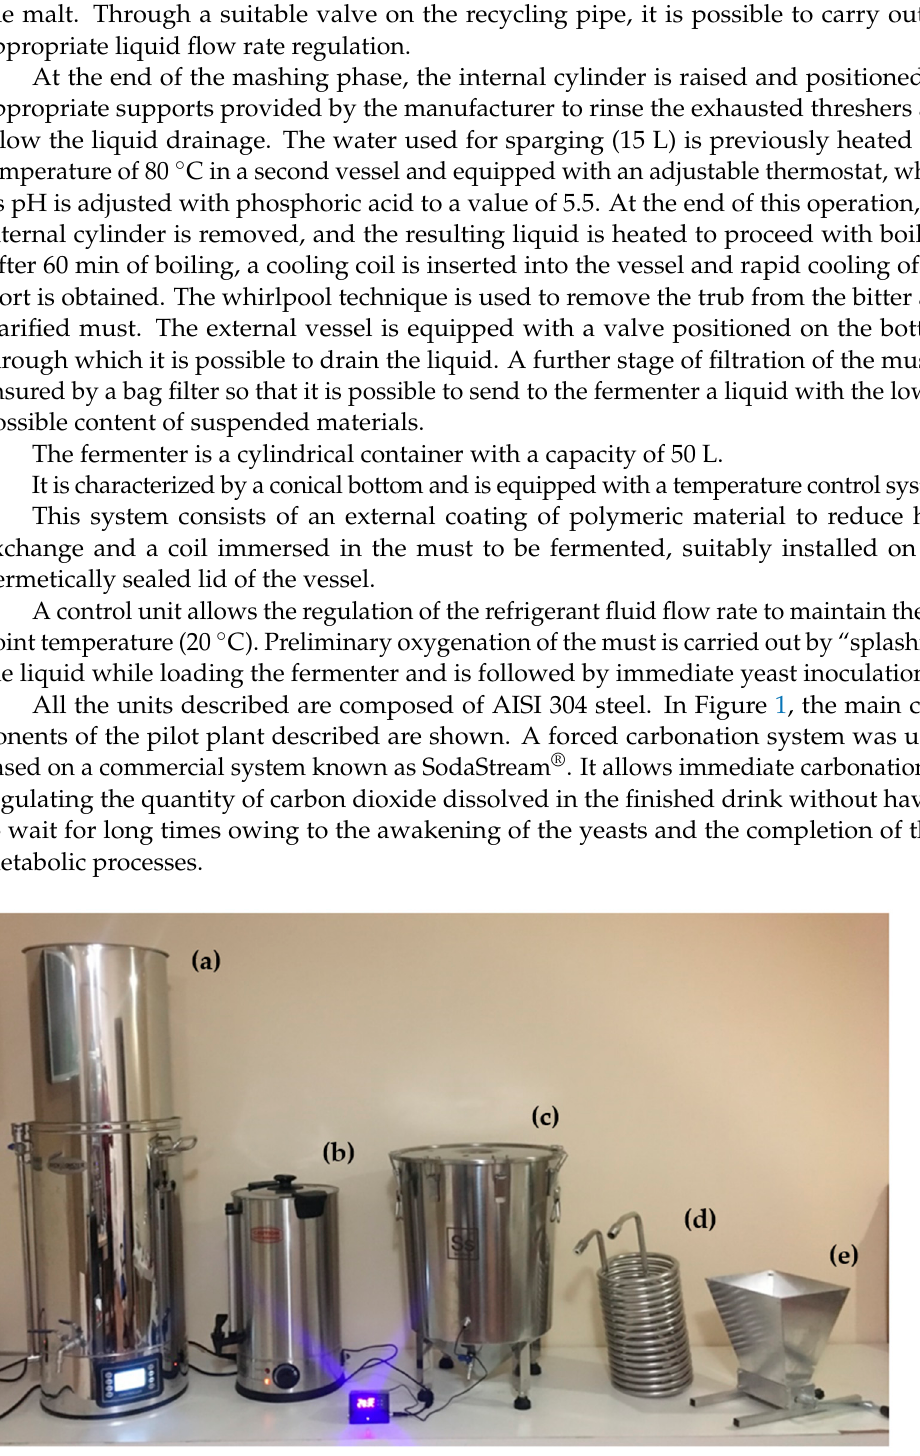
Figure 1. Main components of the pilot plant for beer production used in this work: ( a ) mash tun/lauter tun/kettle system; ( b ) sparger; ( c ) fermenter with temperature control system; ( d ) cooling coil; ( e ) roller mill.